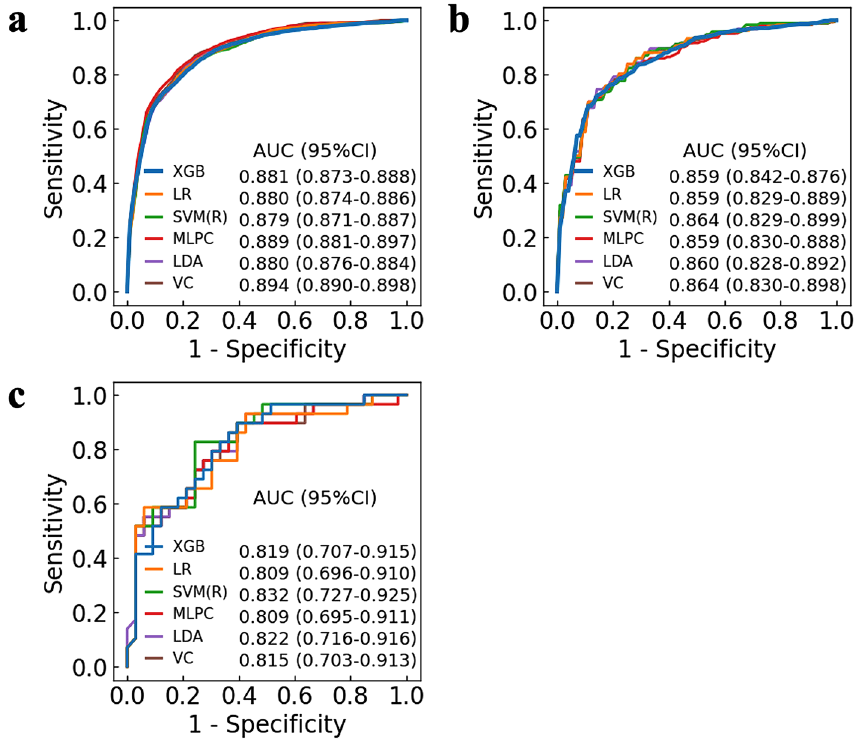
Figure 2. Receiver operating characteristic curve of prehospital diagnostic algorithms for acute coronary syndrome with 17 features. ROC curves of the top six machine learning algorithms for the prehospital prediction of ACS using 17 features are shown. The ROC curves are depicted at 1-specificity on the x-axis and sensitivity on the y-axis using ( a ) the training score, ( b ) the test score, and ( c ) external cohort score. AUC is presented with 95% confidence interval. ACS (acute coronary syndrome), AUC (area under the receiver operating characteristic curve), CI (confidence interval), LDA (linear discriminant analysis), LR (logistic regression), MLPC (multilayer perceptron classifier), ROC (receiver operating characteristic), SVM (R) (support vector machine radial basis function), VC (voting classifier), XGB (eXtreme Gradient